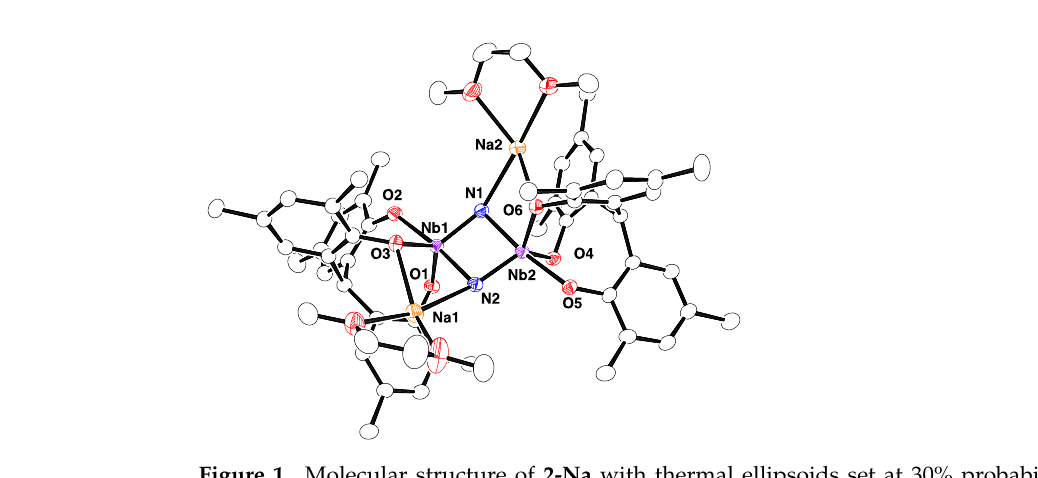
Figure 1. Molecular structure of 2-Na with thermal ellipsoids set at 30% probability level. All hydrogen atoms and methyl groups of tert -butyl groups are omitted for clarity.